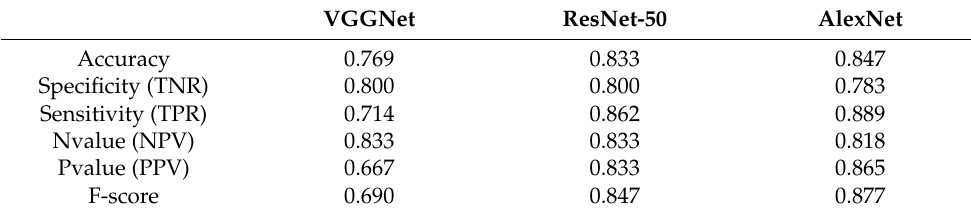
Table 6. Evaluation of three deep networks for feature